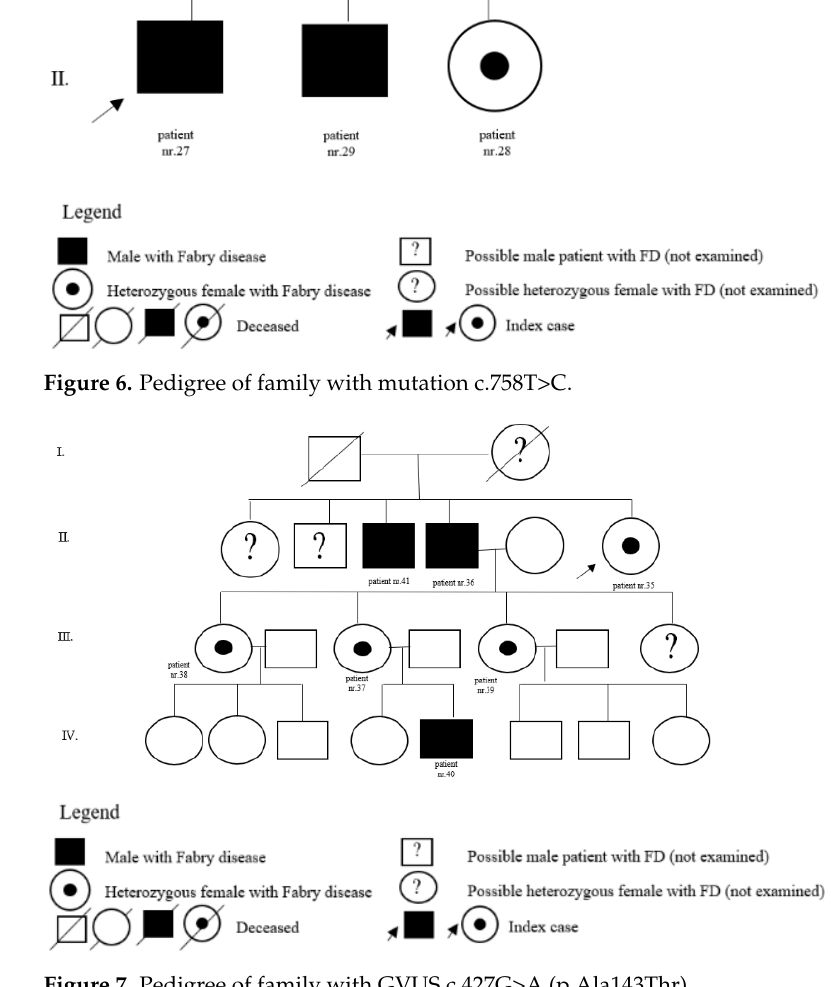
Figure 8. Pedigree of family with GVUS c.427G>A (p.Ala143Thr). In 2021, Slovakia had a population of 5,449,270 inhabitants [19]; the prevalence of the disease in our country can be estimated at 1:113,526. The first FD patient in Slovakia was diagnosed in 1999. In a 20-year-old male with proteinuria, a kidney biopsy revealed a typical histological image of FD. The diagnosis was confirmed with an examination of the enzyme activity of α -Gal A and genetic testing.